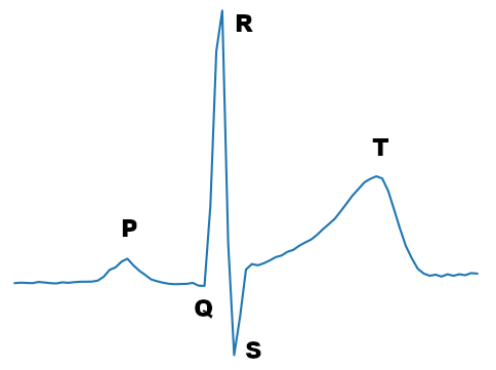
Figure 1. ECG signal